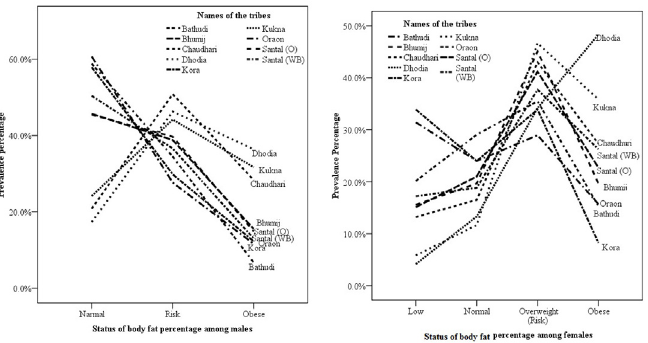
Fig 4. Distribution of body fat percentage under low, avarage, at risk (overweight) and obese categories among men and women of nine tribes.